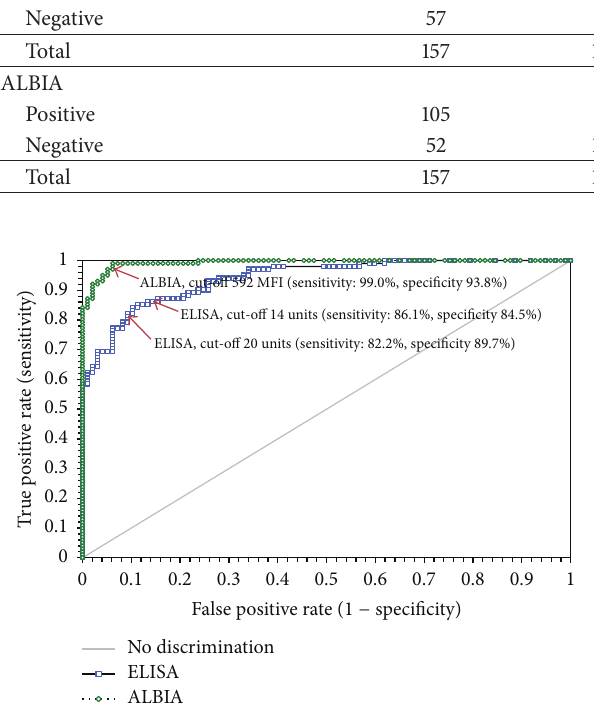
Figure 2: Comparative receiver operating characteristic (ROC) analysis (CBA-IFA positive versus negative samples). The ALBIA and the EUROIMMUN ELISA were compared to the EUROIM- MUN CBA-IFA. The EUROIMMUN CBA-IFA was the first com- mercially available immunoassay for anti-PLA 2 R and therefore was used to define the outcome (anti-PLA 2 R positive versus anti-PLA 2 R negative). With an area under the curve (AUC) of 0.99 (95% CI: 0.99 to 1.00), the ALBIA performed similar to the CBA-IFA assay. The ELISA reached an AUC of 0.94 (95% CI: 0.91 to 0.97). Cut-off values are indicated by the arrows. The ELISA was also analyzed with an alternative (borderline) cut-off of 14